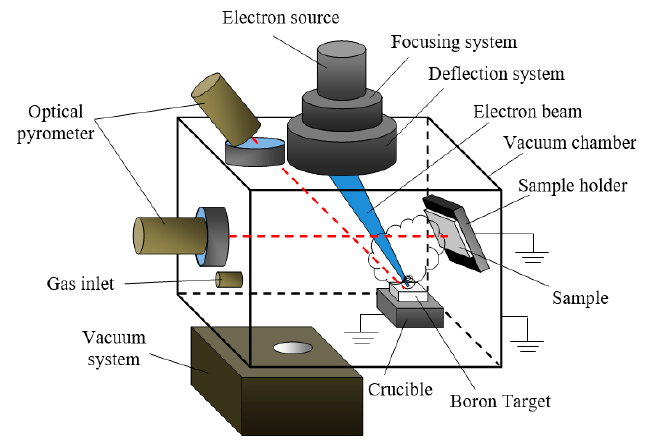
Figure 28. Experimental setup for depositing boron-containing coatings. is shown in Figure 29 [138].